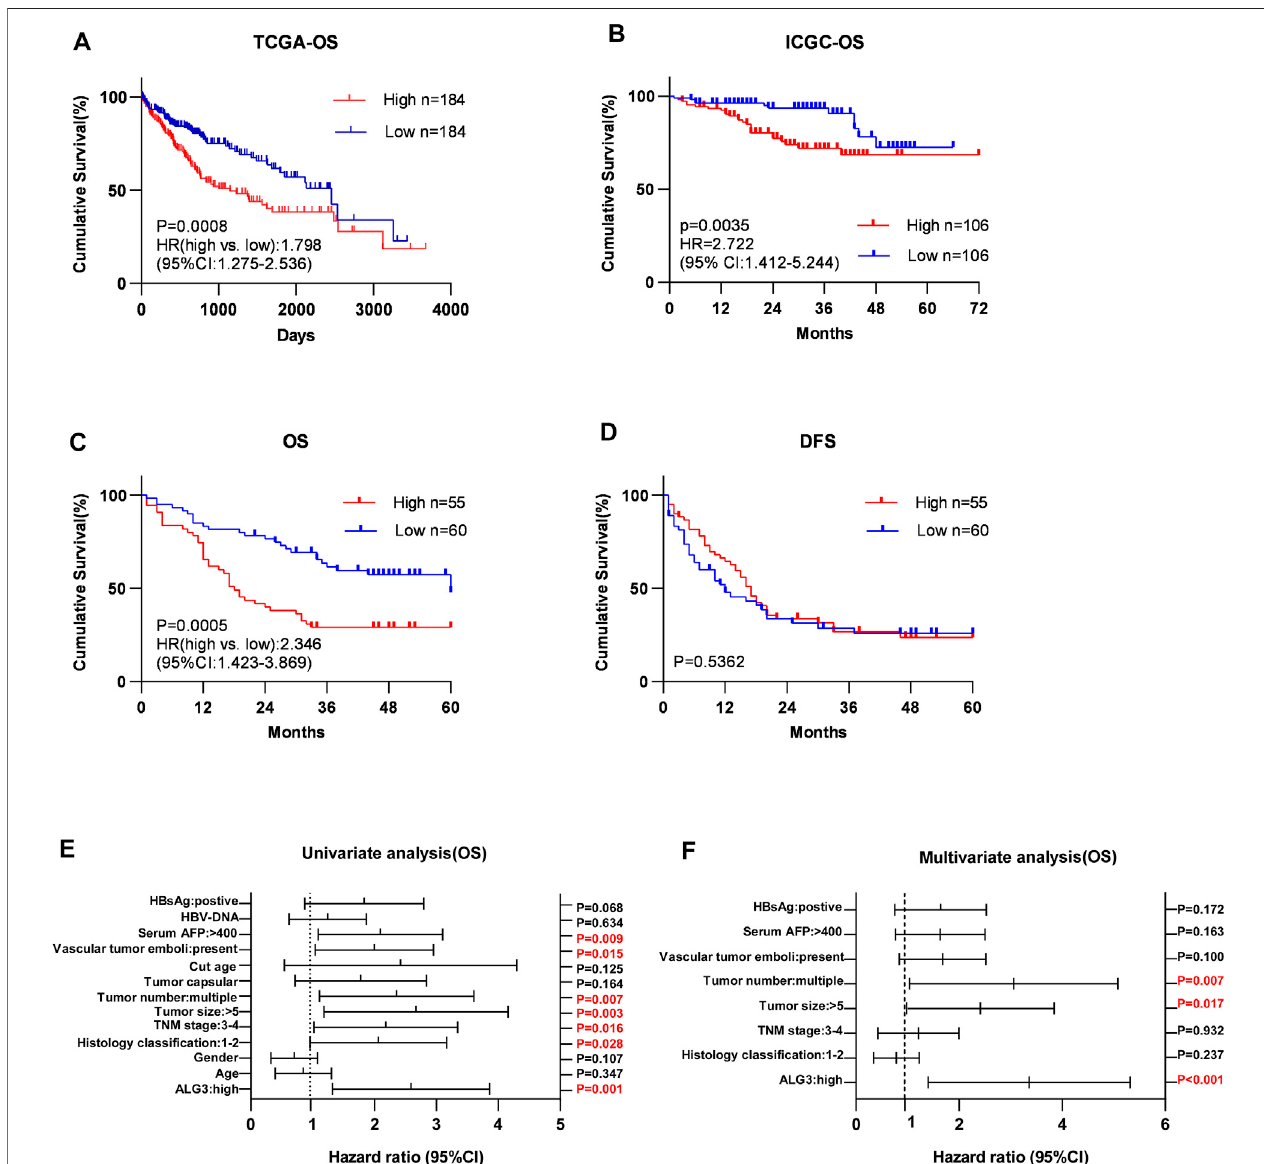
FIGURE4| Over-expressionofALG3iscorrelatedwithpoorprognosisinHCC.Kaplan – Meieranalysisof5-yearoverallsurvivalforHCCintheTCGA-LIHCdataset (A) andICGCdataset (B) .Kaplan – MeieranalysisofOS (C) andDFS (D) forGHPDstrati fi edbylowandhighALG3expressions( n =115,log-ranktest).Univariate (E) and multivariate (F) Cox regression analyses to assess the signi fi cance ofthe association between ALG3 and 5-year overall survival in the presence of other clinical variables.